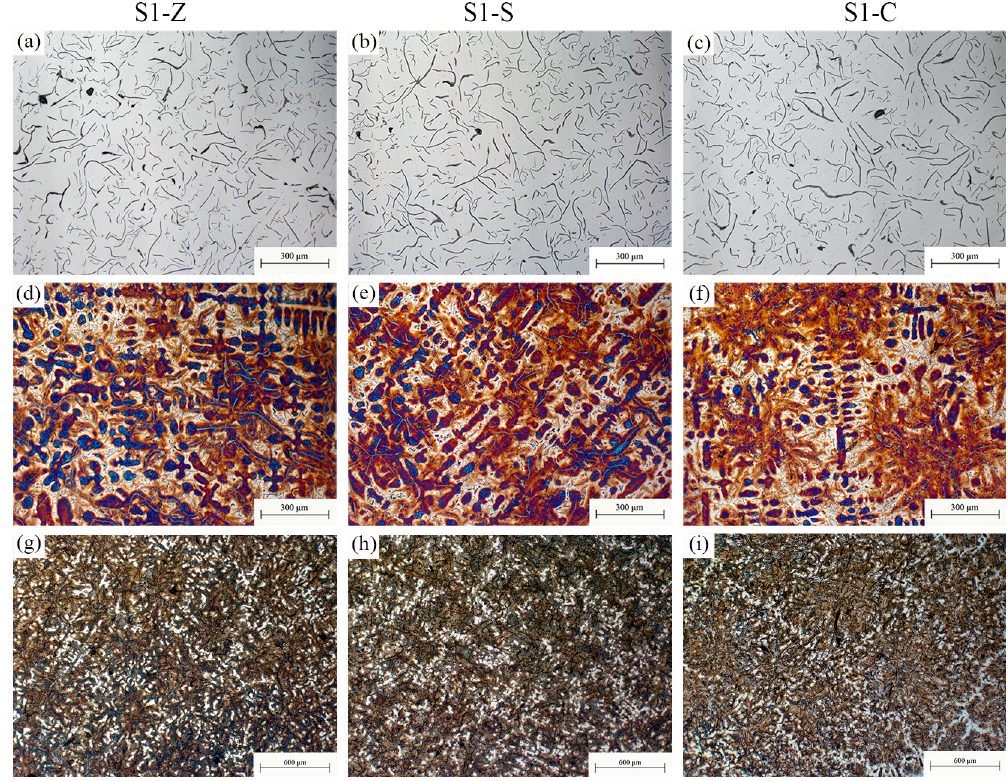
Figure 2. Metallographic images of S1 ‐ Z ( a , d , g ), S1 ‐ S ( b , e , h ) and S1 ‐ C ( c , f , i ), showing graphite ( a – c ), primary dendrite ( d – f ), and eutectic colonies ( g – i ).